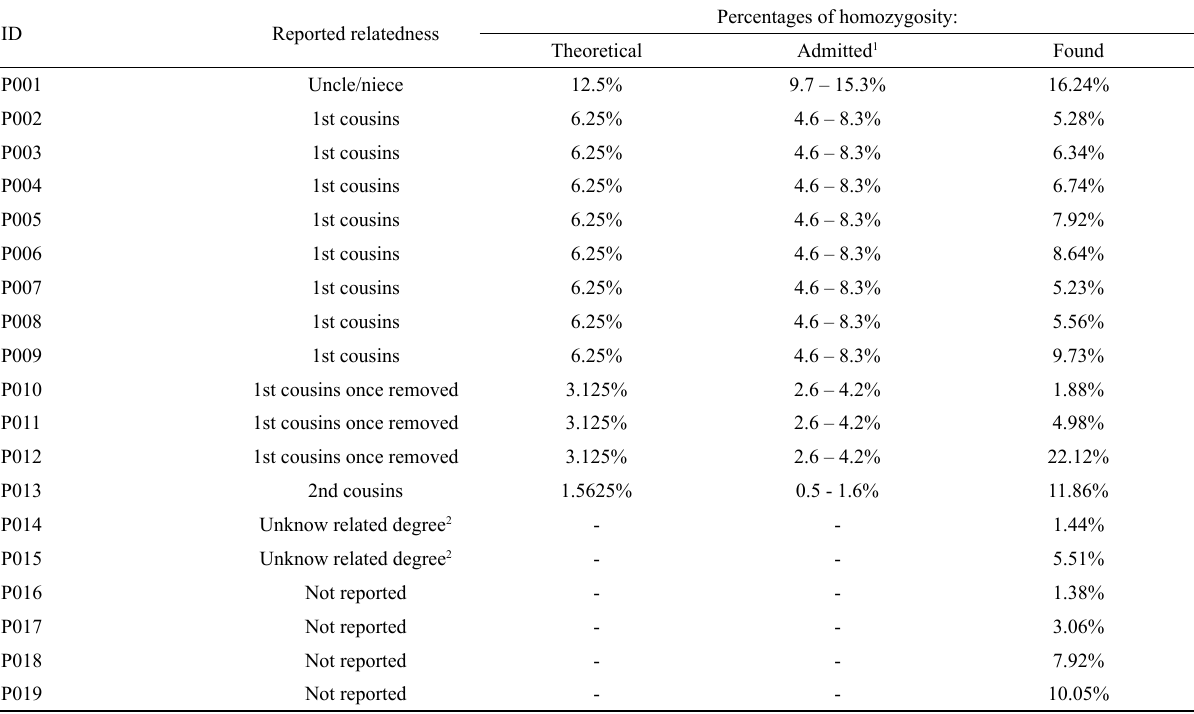
Table 1 – Theoretical, admitted and detected percentages of homozygosis for each